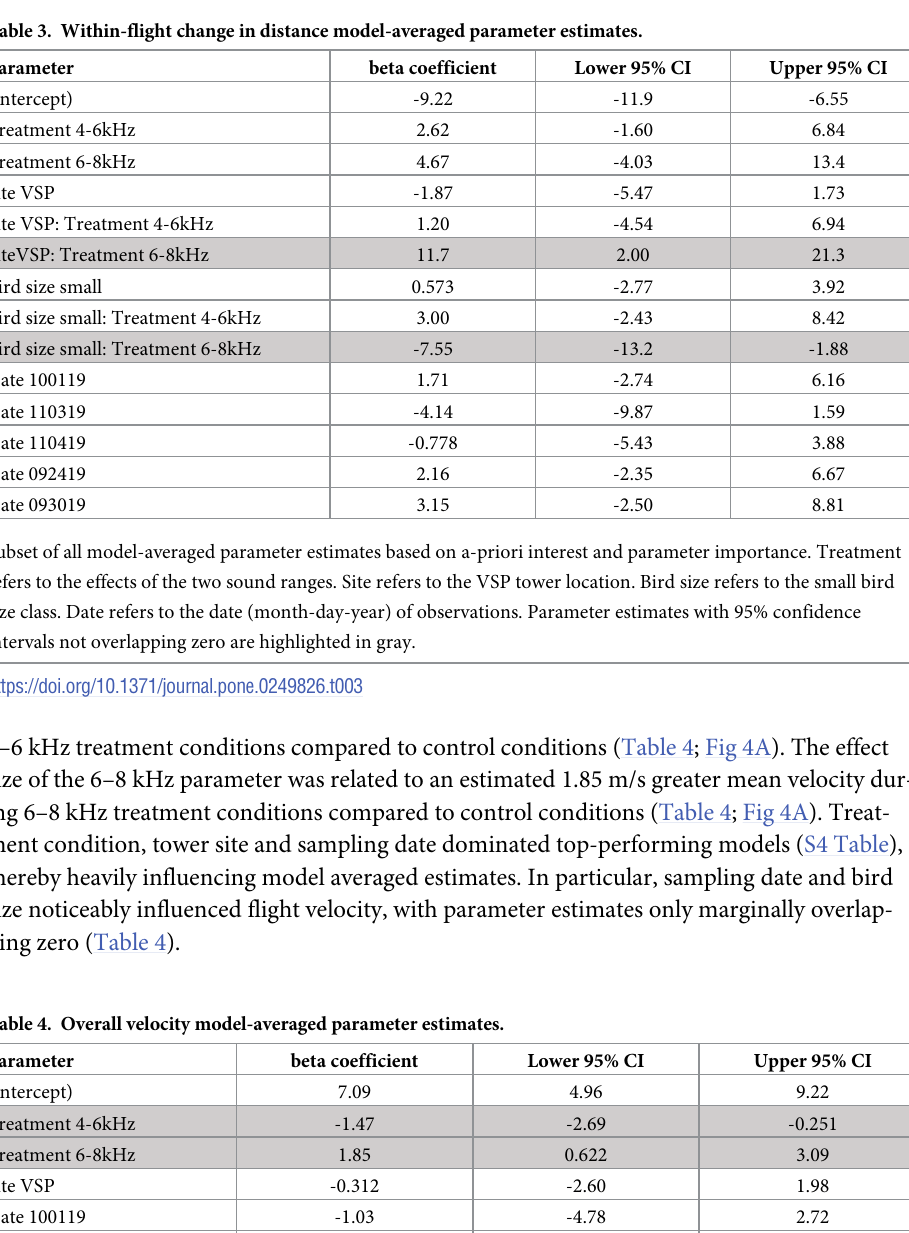
Table 3. Within-flight change in distance model-averaged parameter estimates. Parameter